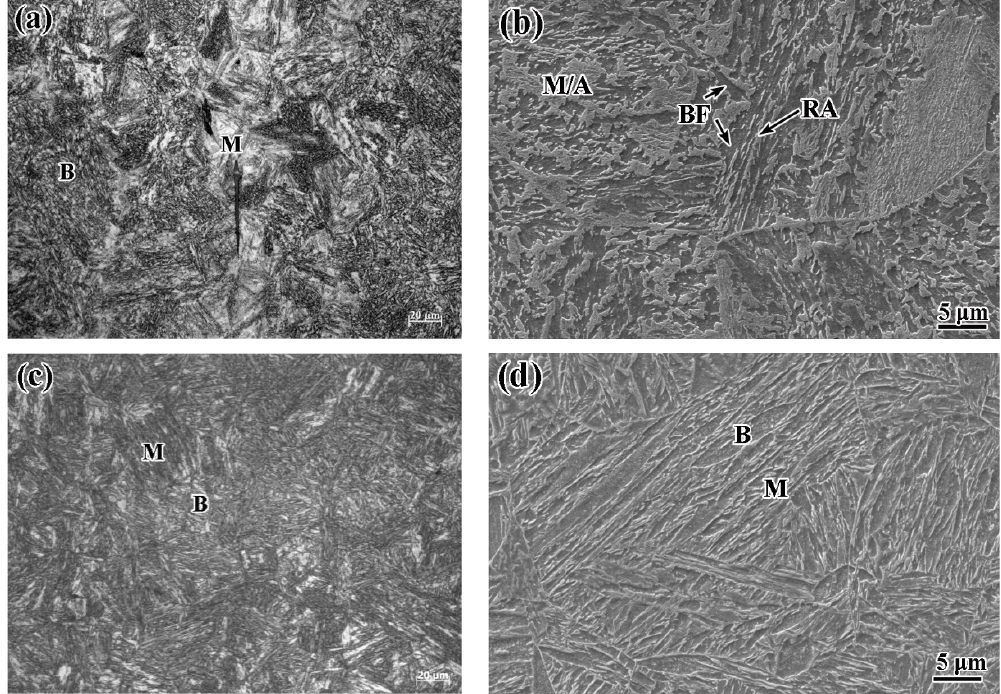
Figure 3. Microstructure of 1280G and 1380G rail steels. ( a , b ) 1280G; ( c , d ) 1380G; ( a , c ) OM images; ( b , d ) SEM images; B: bainite, M: martensite, BF: bainitic ferrite, M/A: martensite/austenite, RA: retained austenite.